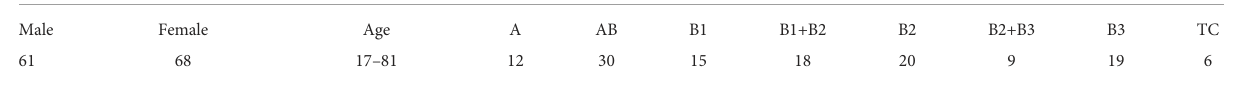
TABLE 1 Clinical information of